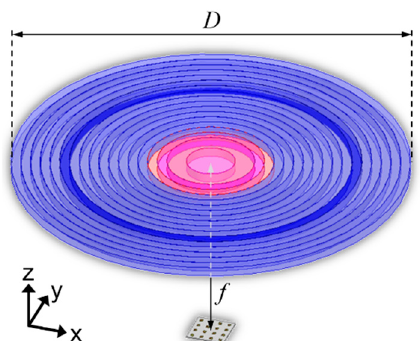
Figure 12. Oblique view of the designed lens.